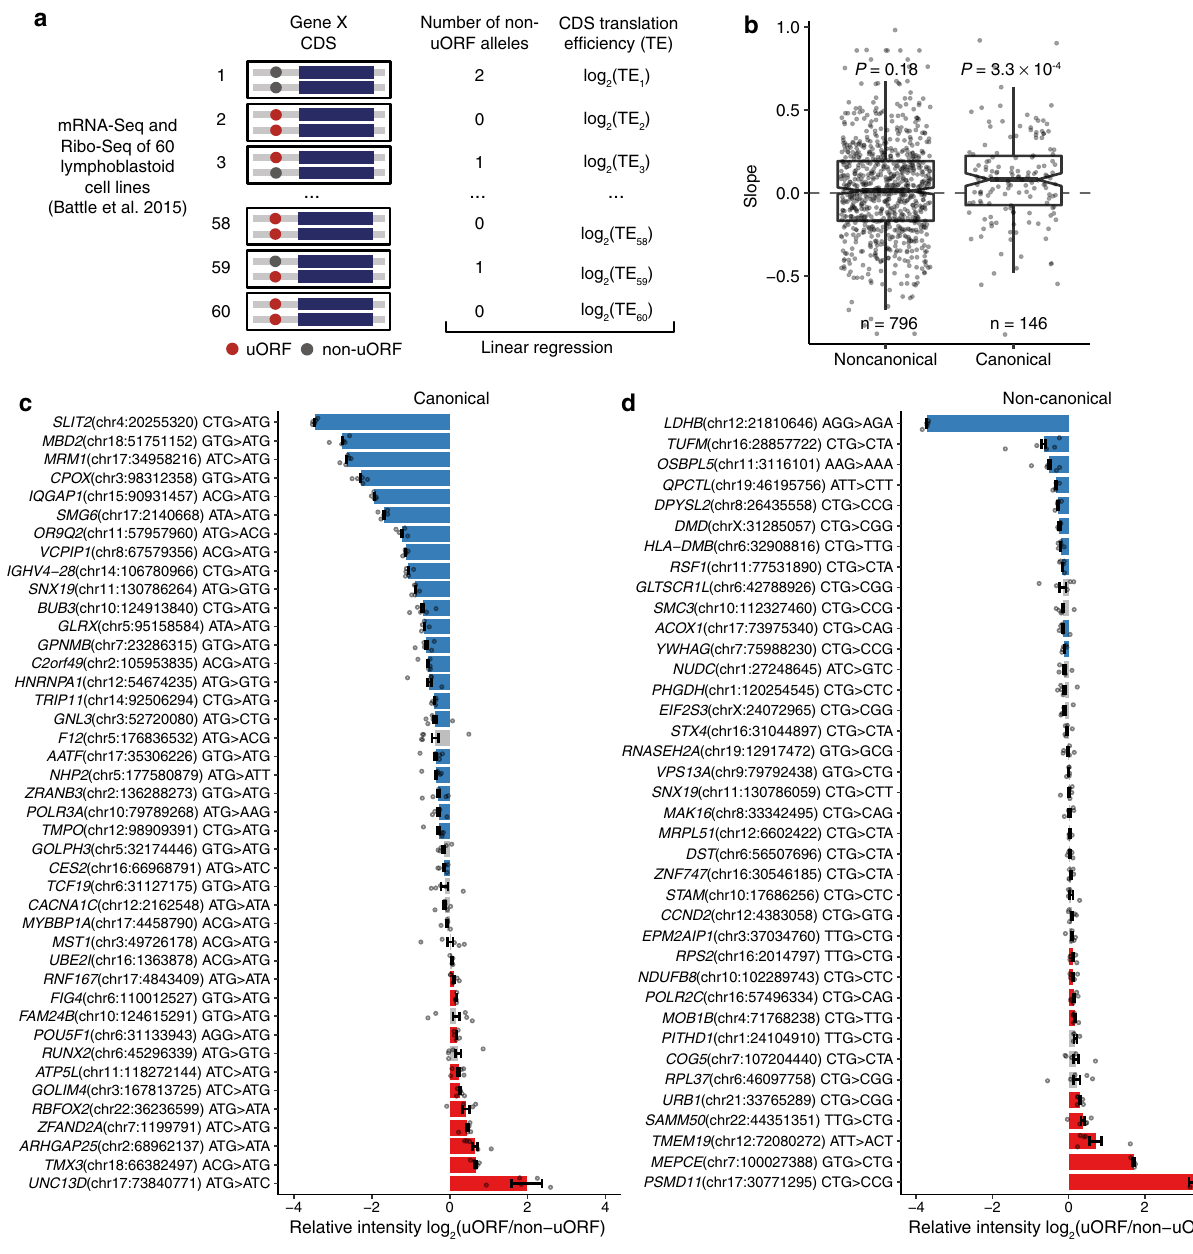
Fig. 7 Experimental veri fi cation of canonical and noncanonical upstream open reading frames (uORFs). a The scheme showing how to determine the effect of uORF variations in the human population on the translation ef fi ciency (TE) of downstream coding sequences (CDSs). With the mRNA-Seq and Ribo-Seq data of 60 human lymphoblastoid cell lines 115 , we calculated the translation ef fi ciency of CDS for each gene and obtained the genotypes of each subject from the 1000Genomes Project. For each uORF variant, we performed a linear regression between the number of non-uORF alleles and the log 2 (TE) of downstream CDS across the 60 cell lines. b The distribution of slopes in the linear regression between genotypes (the number of non-uORF alleles) and CDS translational ef fi ciency among 60 cell lines. Center line, median; box limits, upper and lower quartiles; whiskers, 1.5 times the interquartile range. The number of variants in each category was shown in the plot. Exact P values of two-sided Wilcoxon signed-rank tests were shown in the plot. The ratio of relative luciferase intensity (log 2 ) between the reporters with the uORF allele or the non-uORF allele for each variant of canonical uORFs ( c ) or noncanonical uORFs ( d ). The bars are displayed in blue or red when the relative intensity of uORF-allele is signi fi cantly lower or higher than that of the non- uORF allele (one-sided Wilcoxon rank-sum tests, P adj < 0.1), respectively. Measures of center, mean; error bars, standard errors. n = 4 or 5 independent biological replicates for each variant (details are presented in source data). Source data are provided as a Source Data fi variants in their start codons among these samples (only variants mRNA-Seq, and Ribo-Seq data of 60 human lymphoblastoid cell with minor allele frequency ≥ 5% were considered in the analysis). lines from previous studies 98,115 , and examined whether varia- We performed linear regressions to assess the regulatory impact tions in uORF start codons in fl uence the translation ef fi ciency of of uORF alteration on the translation of down-stream CDSs, with the main CDSs among different samples (Fig. 7a). Among the a positive slope value in the regression meaning that the presence potentially functional uORFs in humans predicted by McGillivray of a uORF in certain individuals is associated with a decrease in et al. 17 , 146 canonical and 796 noncanonical uORFs had genetic